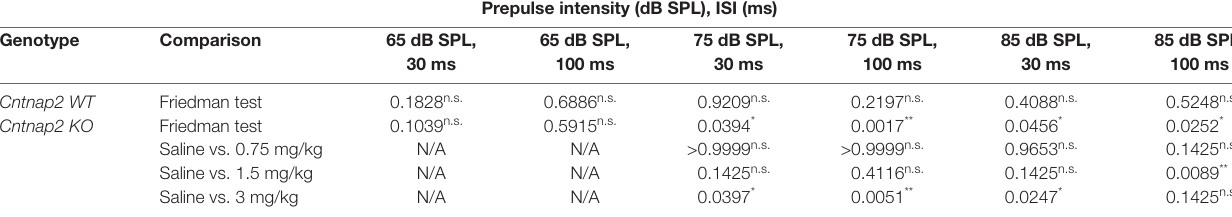
TABLE 6 | Statistical comparison of %PPI within Cntnap2 WT or KO rats after injection of saline, and 0.75, 1.5, and 3 g/kg R-Baclofen. Prepulse intensity (dB SPL), ISI